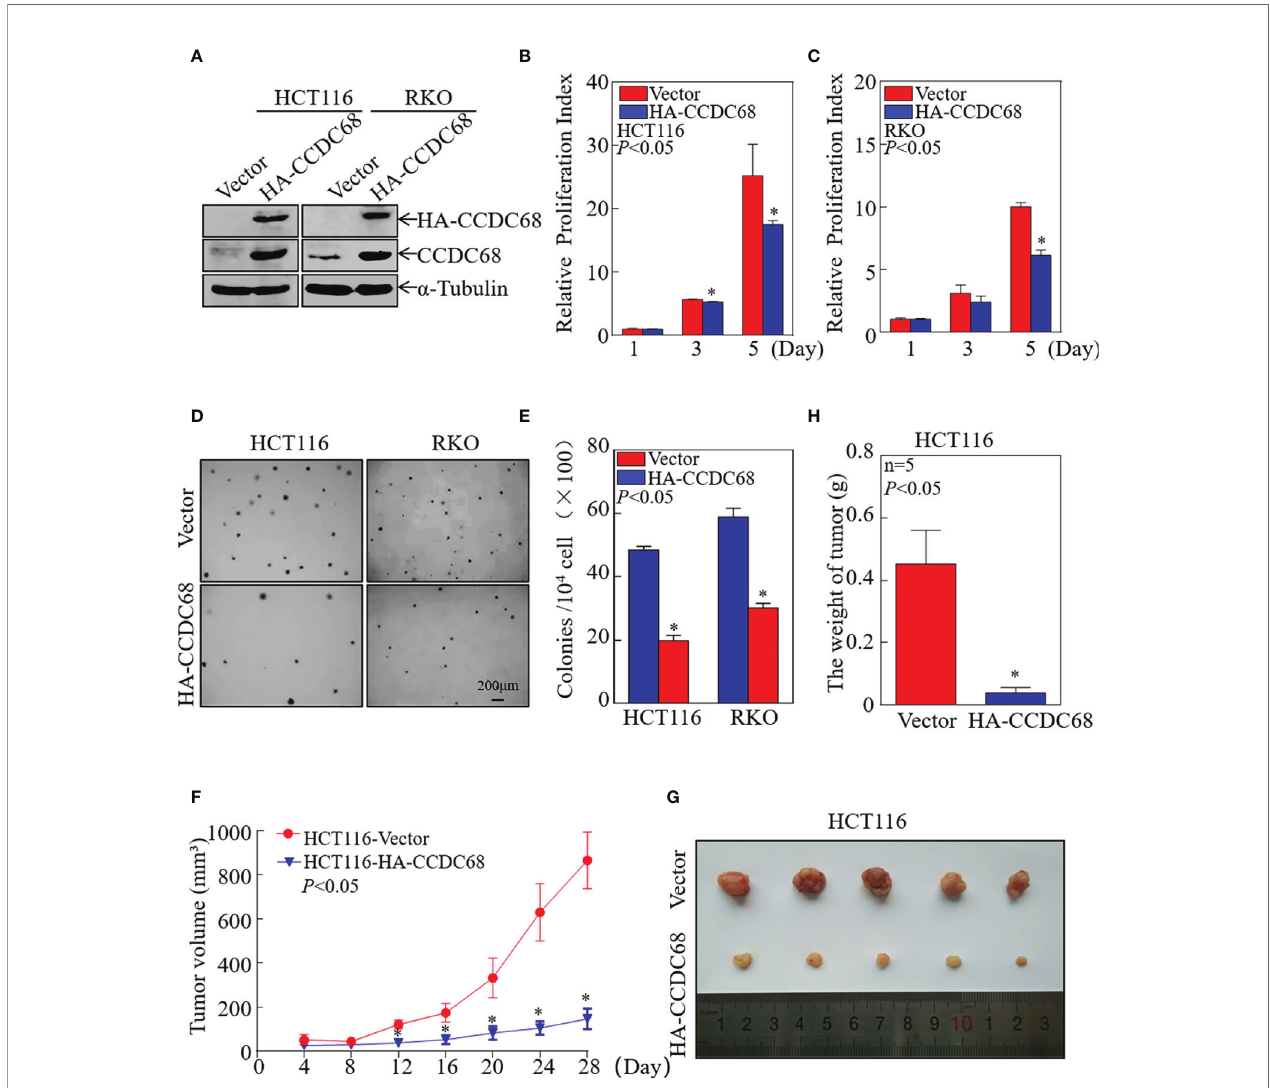
FIGURE 2 | CCDC68 overexpression inhibits CRC cell growth in vitro and in vivo. (A) Stable transfectants of HCT116 (Vector) vs. HCT116 (HA-CCDC68) and RKO (Vector) vs. RKO (HA-CCDC68) were identi fi ed by western blotting. (B, C) Cell proliferation was detected by ATP assay. Data were analyzed Student ′ s t -test. (D, E) Anchorage-independent growth was examined by soft agar assay. Cell colonies were counted, and data were presented as colonies per 10,000 cells and analyzed by Student ′ s t -test. (F) Tumor growth curve for each group. Data were analyzed by Student ′ s t -test. (G) Representative images of tumors in each group. (H) Statistical analysis of tumor mass in each group; n = 5, Student ′ s t -test. Data are presented as the mean ± SD. * P <